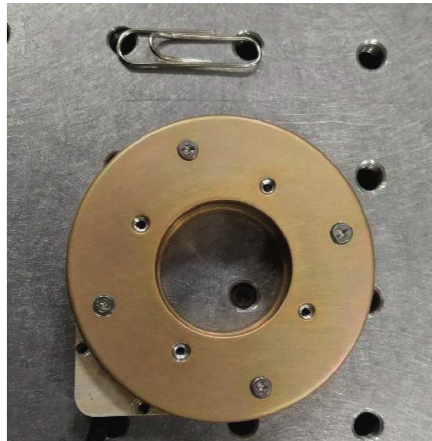
Figure 10: Prototype of the proposed piezoelectric rotary